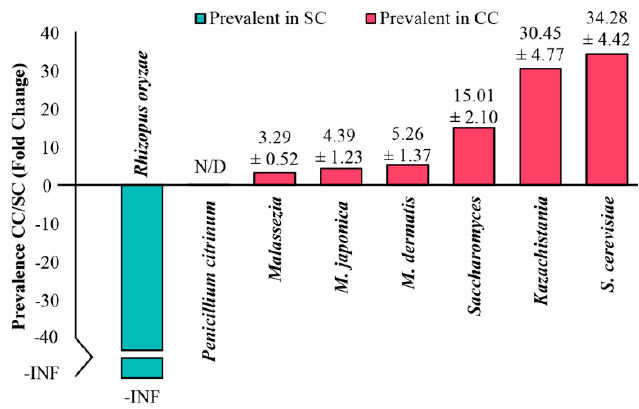
Figure 5. Relative quantification of di ff erent microorganisms in stool samples from SC and CC animals by qPCR. Equimolar samples of DNA extracted from stool samples obtained from each mouse were consolidated into two pools, representing SC and CC groups. Samples from these pools were then used in qPCR experiments, with primers previously described in the literature as specific to Saccharomyces , Kazachstania, and Malassezia genera, as well as to the species Saccharomyces cerevisiae , Malassezia dermatis , Malassezia japonica , Rhizopus oryzae, and Penicillium citrinum . The Ct values obtained for each of these taxa were normalized by the Ct obtained after amplifying the pooled DNAs with the primer pair used to amplify the fungal ITS1 amplicons. Next, the normalized Cts were used to calculate the relative prevalence of each genus / species in the CC pool, in relation to the SC pool (CC / SC). The relative quantification values for each taxon (Fold Change) are shown in the graph, as the mean ± standard deviation of three independent experiments (each performed in triplicate). The species Rhizopus oryzae was detected only in the DNA pool from SC animals, so its CC / SC ratio is represented in the graph as negative, to infinity (-INF). The species Penicillium citrinum was not detected (N / D) in any of the experiments, with either DNA pool.